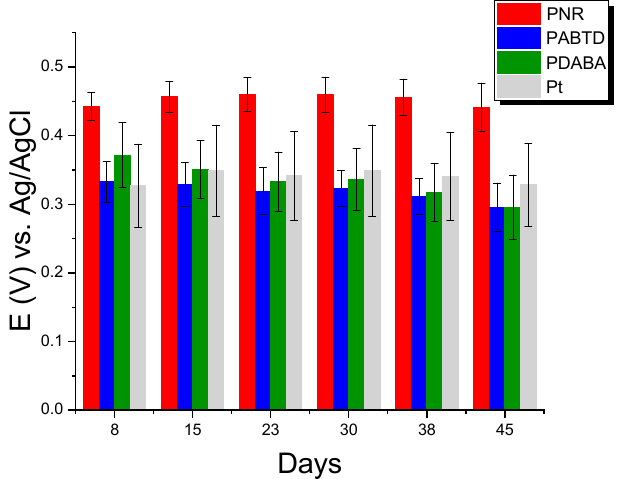
Figure 3. Potential response stability for all types of investigated electrodes over time, measured in acetate buffer pH 4.0, n = 3. acetate buffer pH 4.0, n =